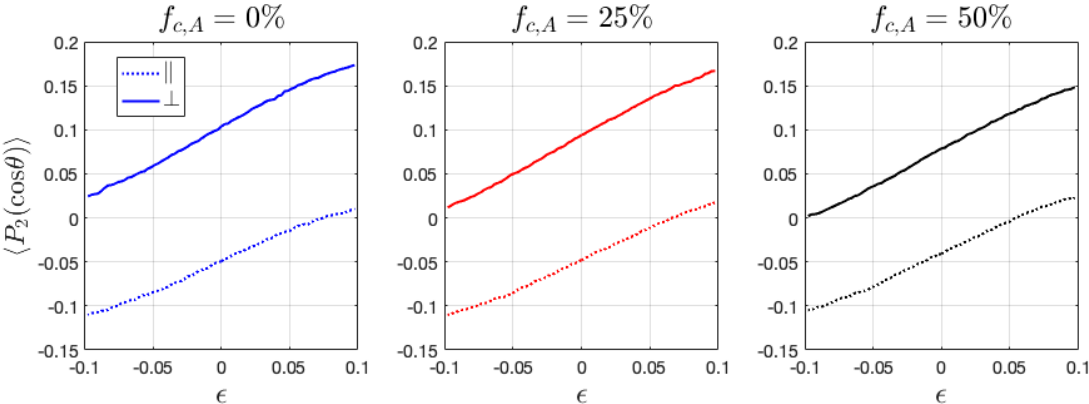
Figure 12. The change of bond orientation during the tension and compression of ionic BCPs with varying charge ratio f c , A